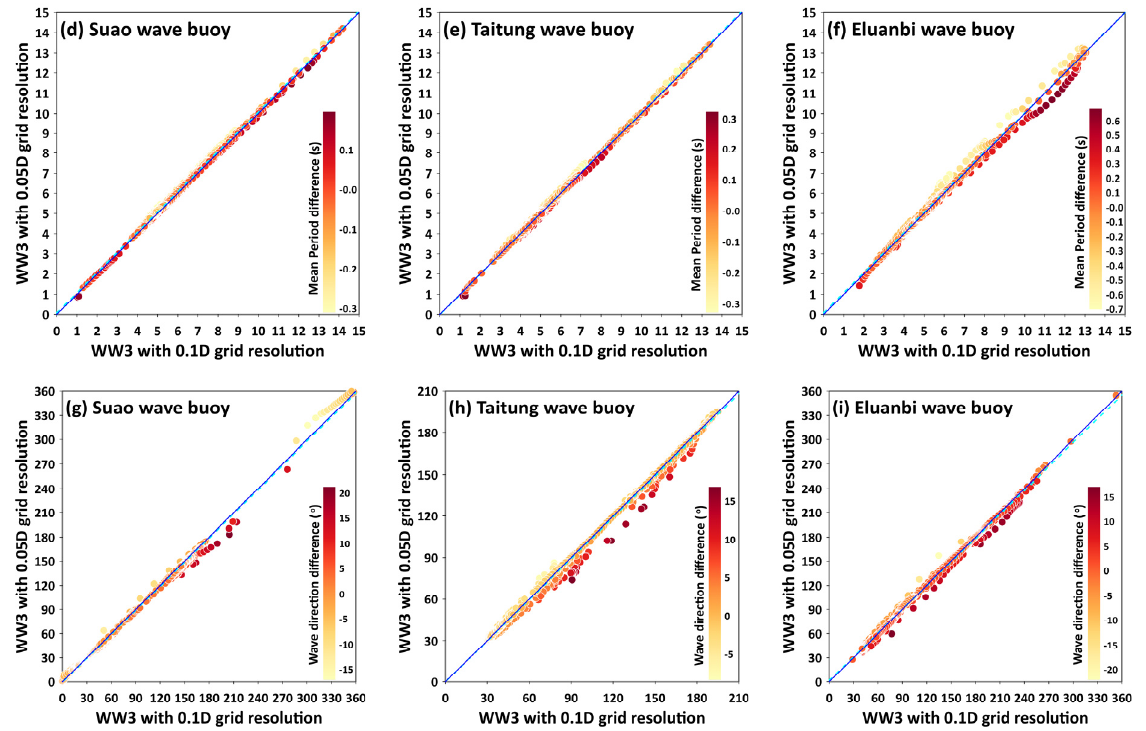
Figure 17. Comparison of the hourly significant wave height ( a – c ), mean period ( d – f ), and wave direction ( g – i ) simulated by the WW3 model with 0.10 deg and 0.05 deg grid resolutions for the ( a , d , g ) Suao, ( b , e , h ) Taitung, and ( c , f , i ) Eluanbi wave buoys.